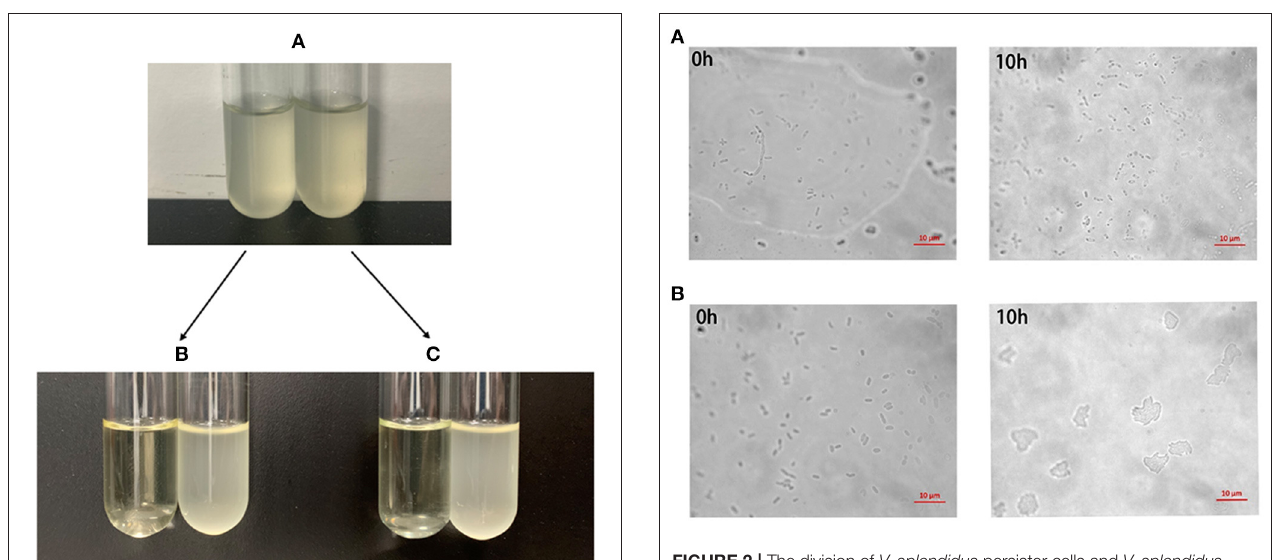
FIGURE 2 | The division of V. splendidus persister cells and V. splendidus exponential cells in the lack of nutrition. (A) Division of V. splendidus persister cells on M9 minimal gel pads that without nutrition at the time points of 0h and 10h, respectively. (B) Division of V. splendidus exponential cells at time points of 0h and 10h in the lack of nutrition. Scale bar indicates 10 µ